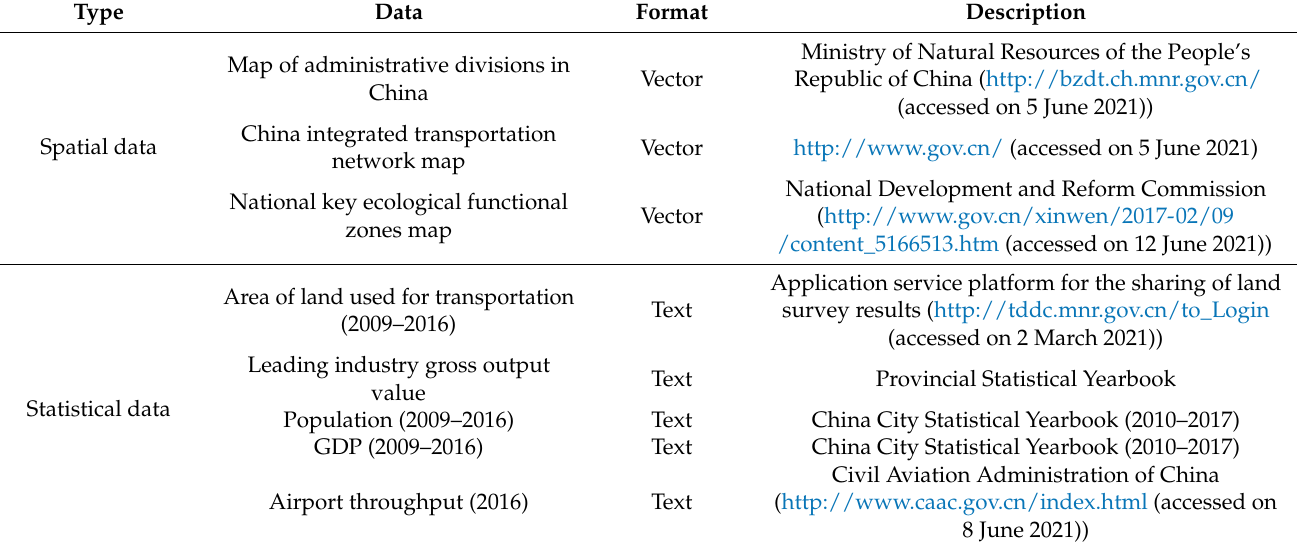
Table 1. Descriptions of data types